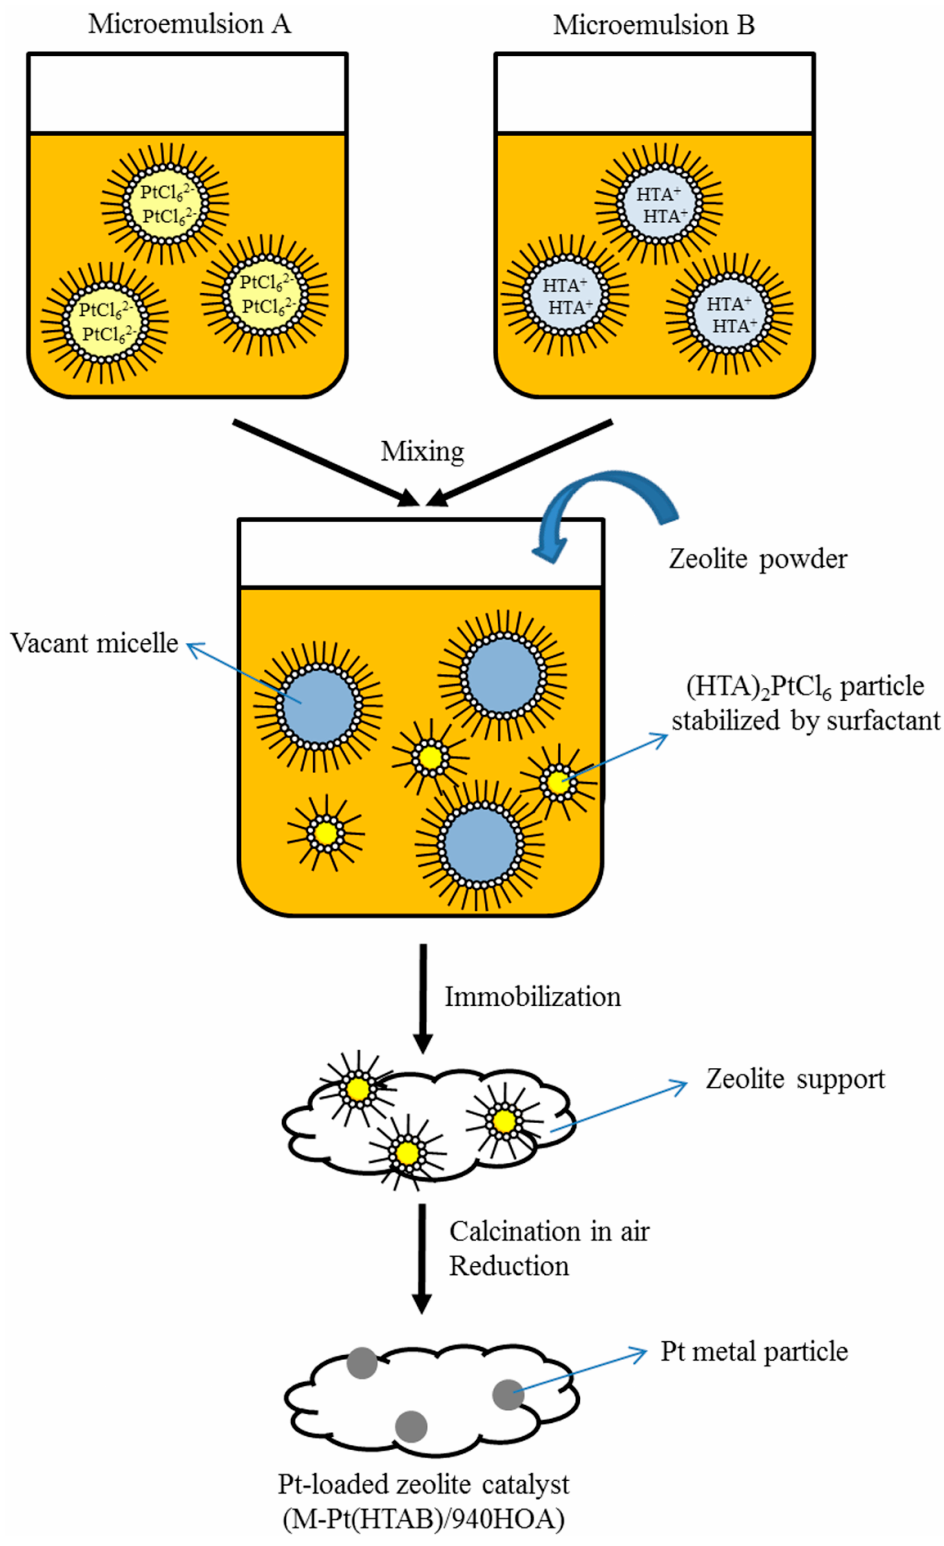
Figure 8. Preparation scheme of Pt-loaded zeolite catalysts using microemulsions (complex-forming agent: